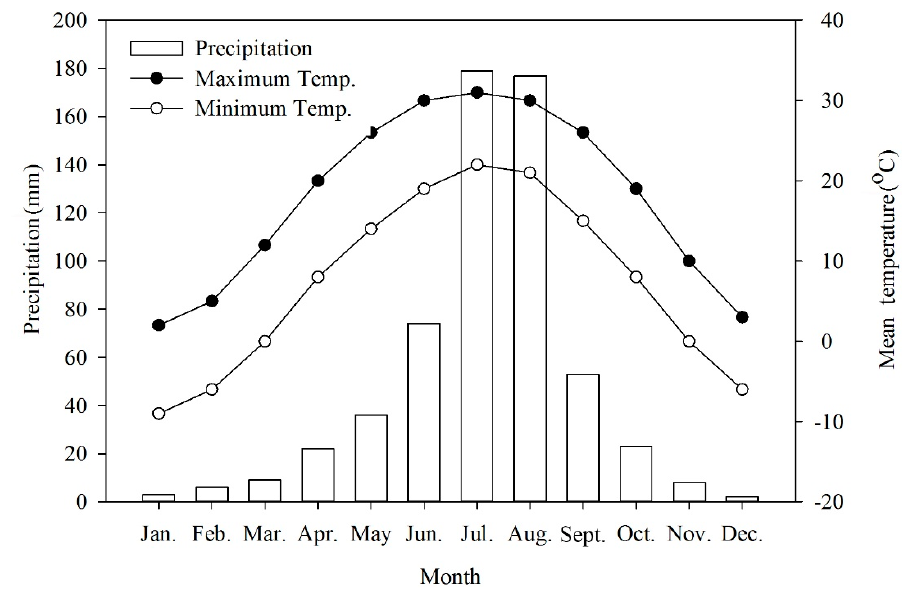
Figure 6. Mean precipitation and maximum and minimum temperatures in Beijing, China.